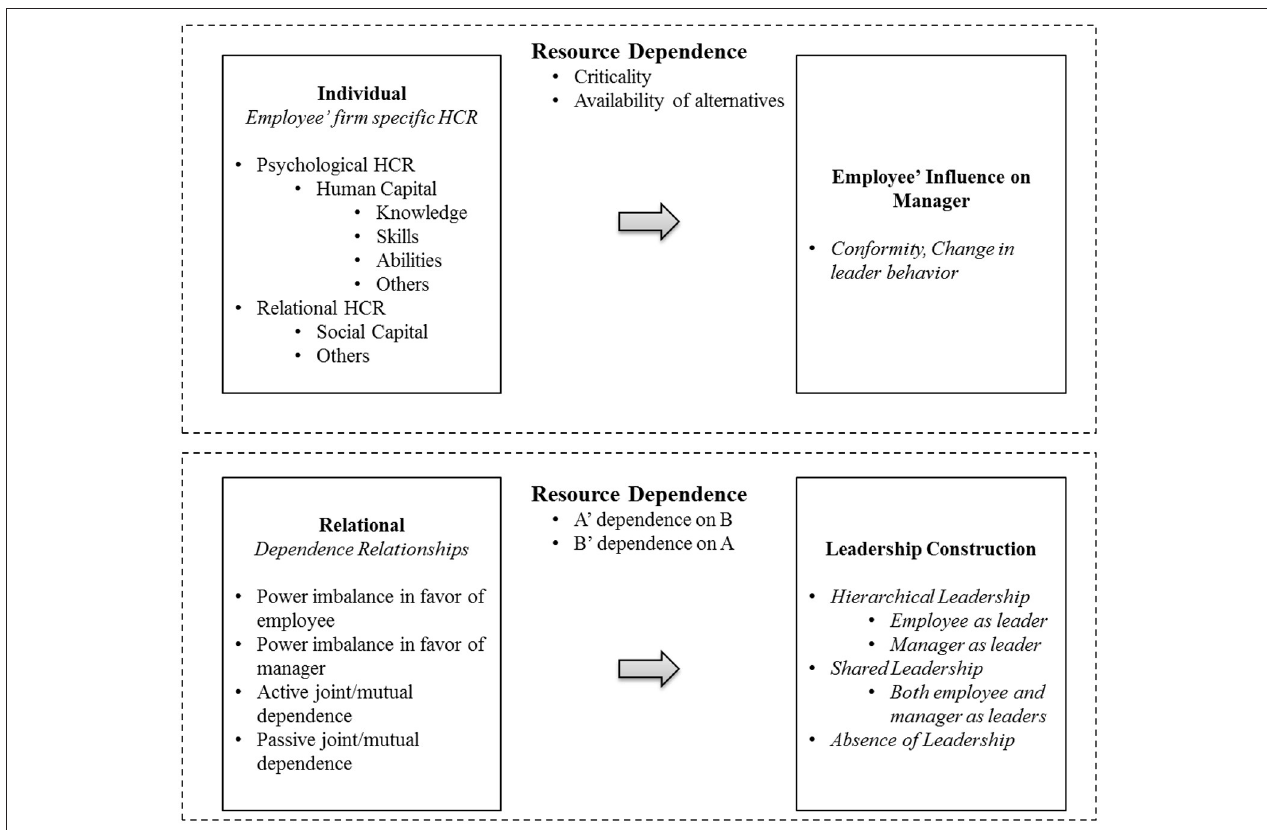
FIGURE 1 | Employee influence on a manager: A resource-dependence